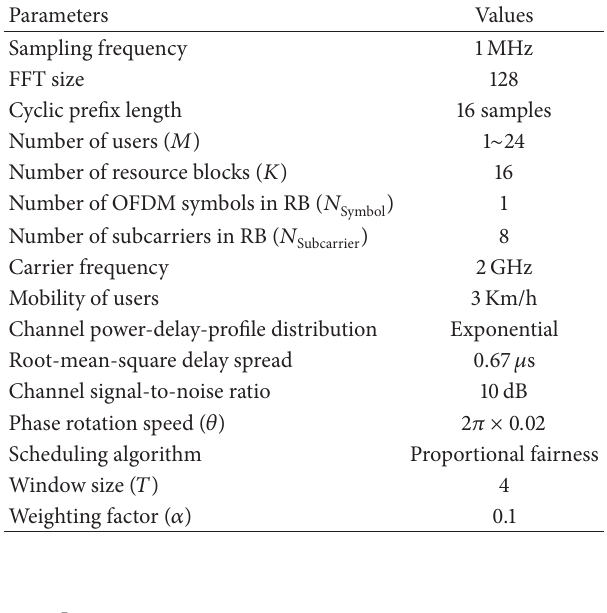
Table 1: Simulation parameters.